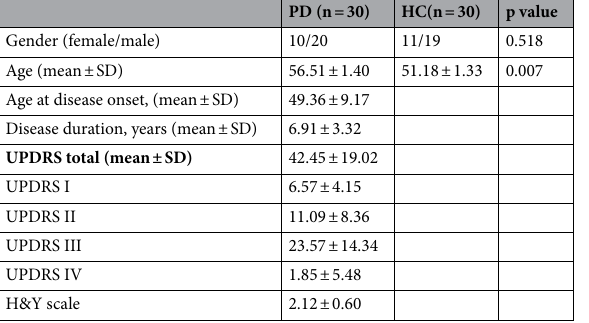
Table 2. Clinical and demographical characteristics of participants. H&Y Scale Hoehn and Yahr Scale, HC healthy controls, UPDRS :Unified Parkinson’s Disease Rating Scale, PD Parkinson’s